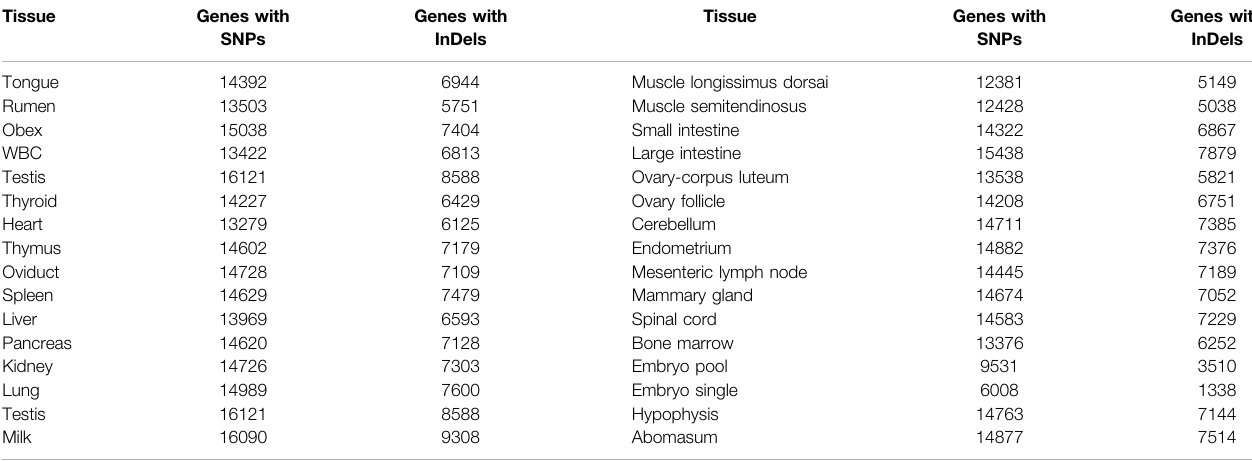
TABLE 3 | Annotated genes with abundance of extracted SNP/InDels from buffalo tissues. Tissue